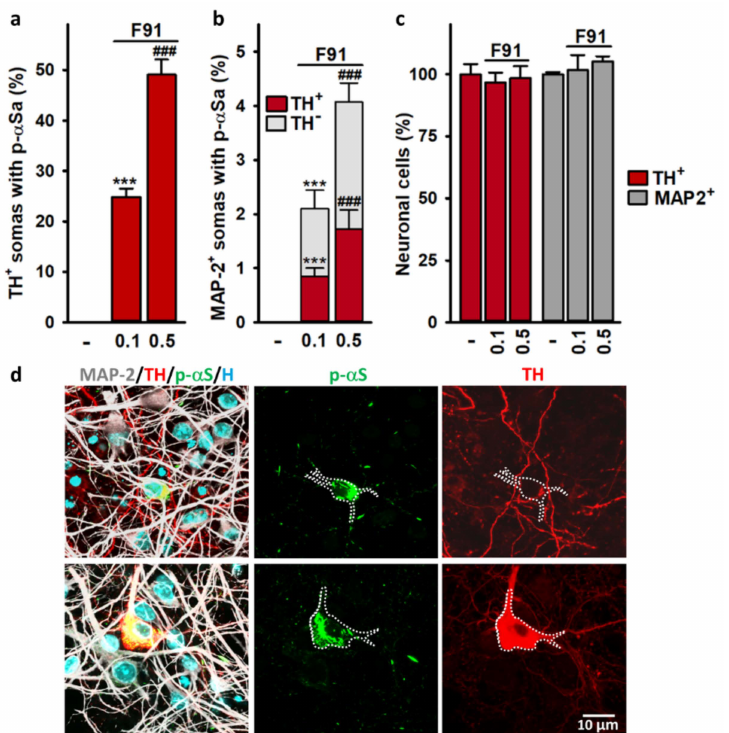
Figure 4. Comparative assessment of α S seeded aggregation in dopaminergic and non-dopaminergic neurons in midbrain cultures. ( a ) Number of dopaminergic (TH + ) somas containing large α Sa in three-week midbrain cultures exposed or not exposed two weeks earlier to 0.1 and 0.5 µ M F91. Data are means ± SEM ( n = 4–6). *** p < 0.001 vs. controls; ### p < 0.001 vs. 0.1 µ M F91. One-way ANOVA followed by SNK test. ( b ) Stacked bar graph showing the percentage of dopaminergic (TH + ) and non-dopaminergic (TH − ) somas with aggregates among MAP-2 + neurons in three-week midbrain cultures exposed two weeks earlier to 0.1 and 0.5 µ M F91. Data are means ± SEM ( n = 4–6). *** p < 0.001 vs. controls; ### p < 0.001 vs. 0.1 µ M F91. One-way ANOVA followed by SNK test. ( c ) Number of TH + and MAP-2 + neurons in three-week midbrain cultures treated or not treated with 0.1 or 0.5 µ M of F91 two weeks earlier. Data are means ± SEM ( n = 4–6). ( d ) Merged and single-color images from three-week midbrain cultures exposed two weeks earlier to 0.1 µ M F91 and then immunostained for MAP-2 (light grey), p- α S (green) and TH (red). Nuclear counterstaining (blue) is with Hoechst 33342. Top panel : Somal p- α Sa in a MAP-2 + neuron immuno-negative for TH. Bottom panel: Somal p- α Sa in a MAP-2 + neuron immunopositive for TH. In single-channel images from the top and bottom panels dotted lines indicate the virtual boundaries of MAP-2 + cell bodies with α S